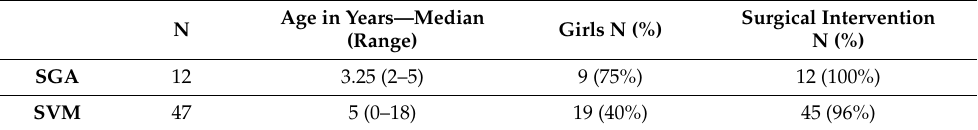
Table 1. Characteristics of patients with subcutaneous granuloma annulare (SGA) and low ‐ flow subcutaneous vascular malformations (SVM) who underwent MR imaging.